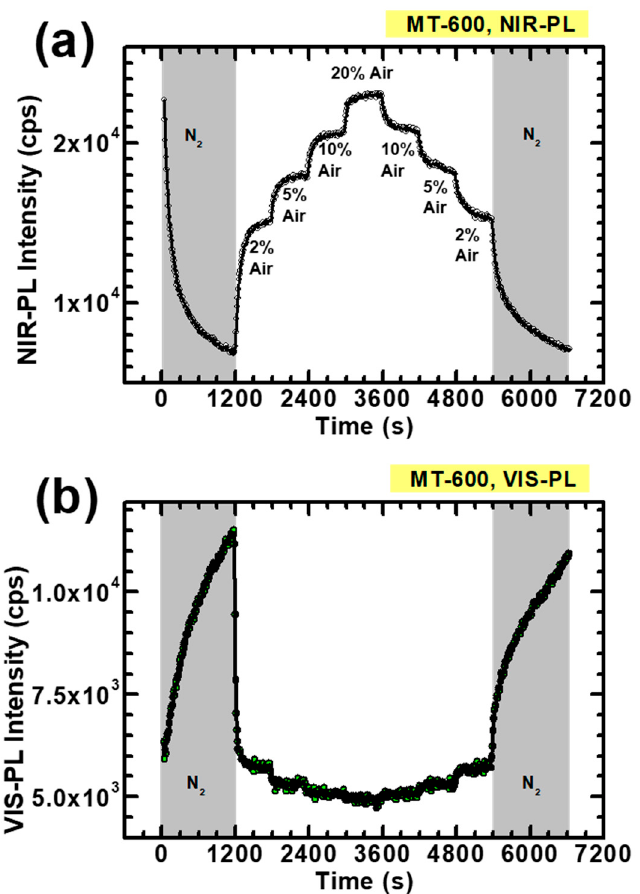
Figure 12. Time dynamics of the NIR-PL emission ( a ) and of the VIS-PL emission ( b ) during exposure of MT-600 to variable concentrations of dry air: The highlighted gray regions indicate exposure to pure nitrogen.